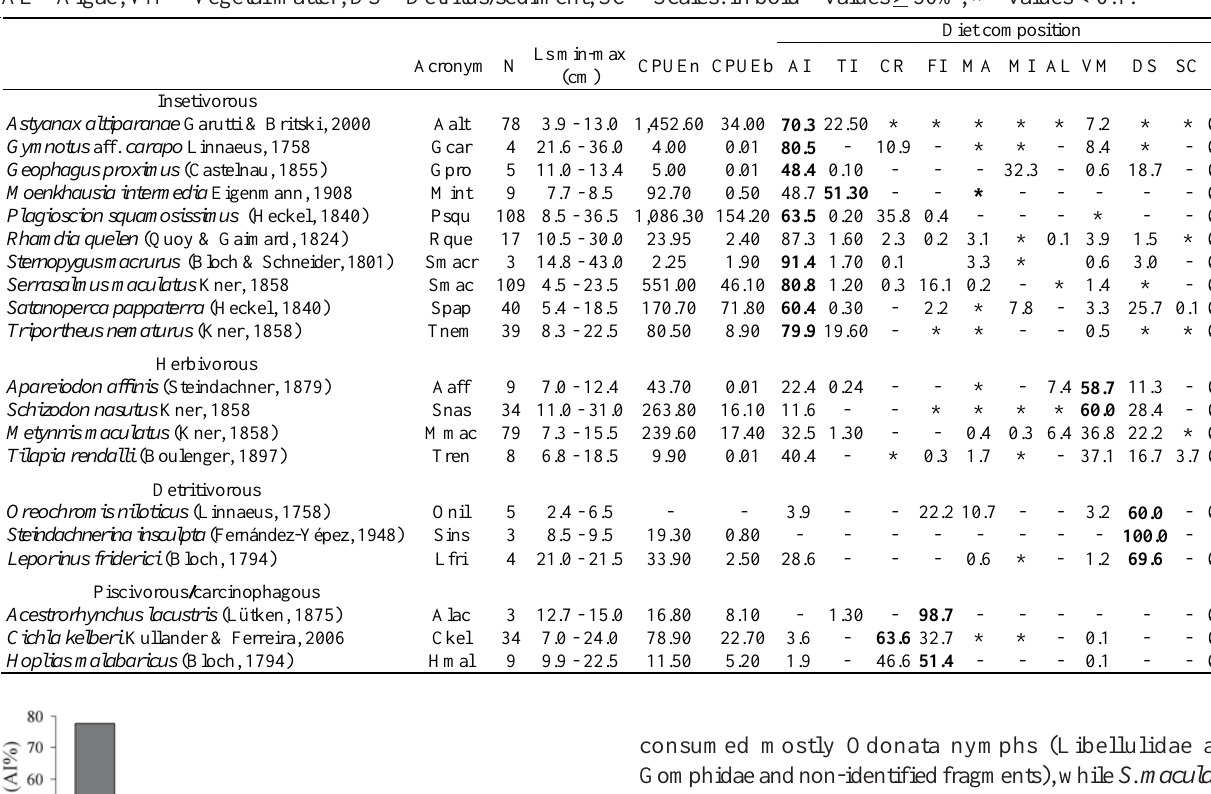
Table 1. Number of stomachs analyzed, standard length (Ls) width (cm), CPUE in number and biomass and diet composition (relative Alimentary Index) and Niche Breadth (B) of the fish species from the Nova Avanhandava Reservoir. Food categories: AI = Aquatic insect; TI = Terrestrial insects; CR = Crustaceans; FI = Fish; MA = Macroinvertebrates; MI = Microcrustaceans; AL = Algae; VM = Vegetal matter; DS = Detritus/sediment; SC = Scales. In bold = values > 50%; * = values < 0.1.